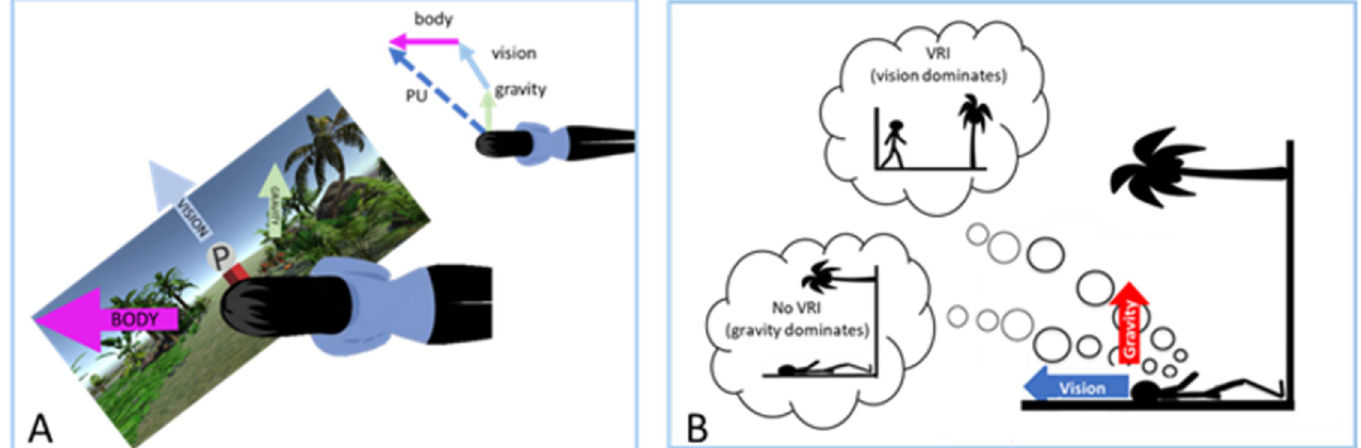
Fig 1. Determining upright. Both panels depict different ways a person might determine where “up” is. Panel A illustrates how the cues to “up” can be separated into different directions. In this case, a person is lying on their left side while viewing a visual environment tilted at 45 degrees. By measuring the PU as these orientations are varied, the relative strengths of their various contributions can be calculated by simple vector geometry as show in the inset. Panel B provides an example of a visual reorientation illusion (VRI). A person is lying on their back in a room that has been tilted such that the visually signalled direction of up aligns with their body orientation. The visual cues in the environment (blue arrow) indicate that the person is upright while the up denoted by gravity (red arrow) signals that the person is lying down. Reliance on the blue arrow results in a VRI while reliance on the red arrow results in no VRI.